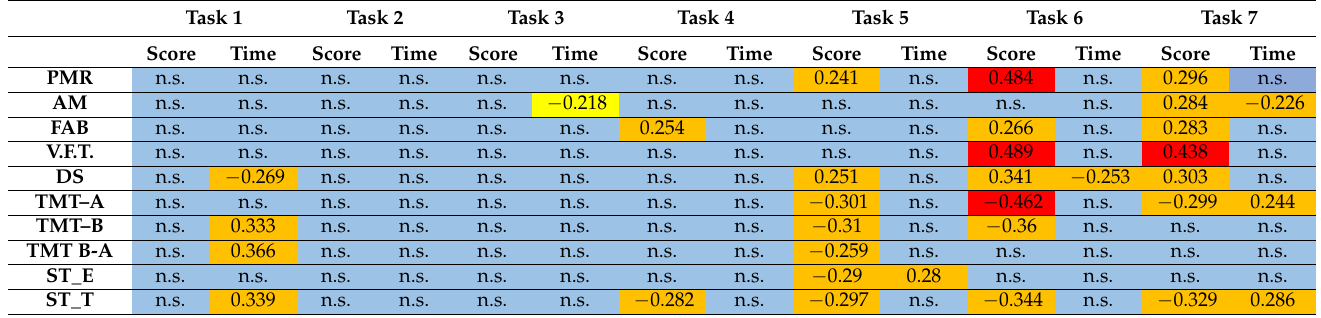
Table 6. Correlation between subtask scores and neuropsychological assessment. Correlation signifi- cances are represented by colors: blue = not statistically significant scores; yellow = scores tending to statistical significance; orange = p < 0.05; red = p <